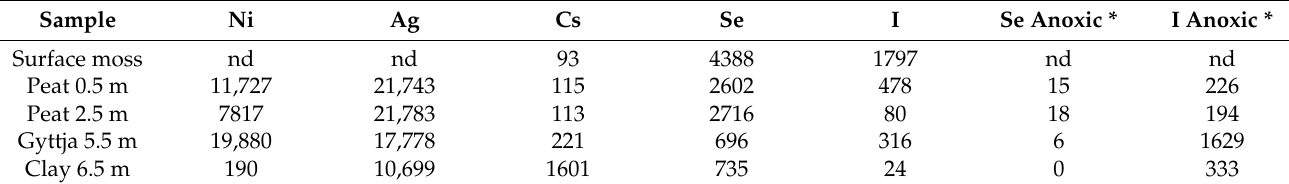
Table 2. Geometrical mean of sorption data (K d values L/kg DW, three replicate samples) for Ni, Ag, and Cs (this paper), and Se, I, anoxic Se, and anoxic I (data from in [80,119]) after 7 days of incubation at 20 ◦ C.